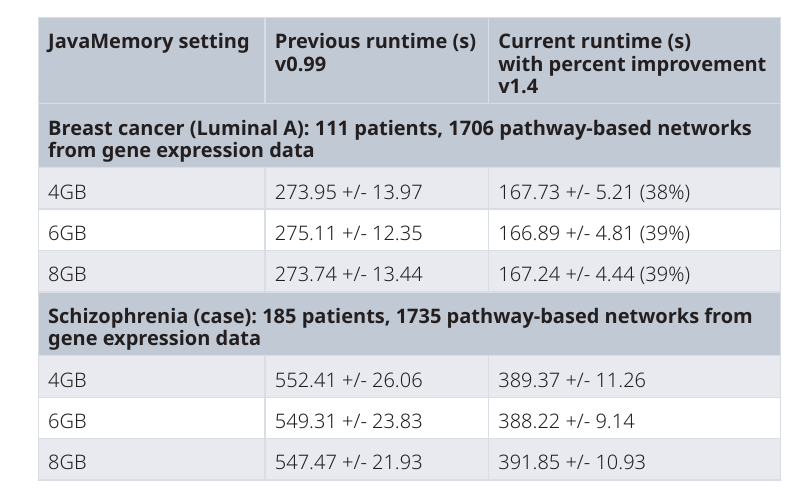
Table 2. Benchmarking performance improvement for netDx. Computation times are averaged over four runs of the same ten queries for feature-scoring one patient label, while limiting the executable to a single core. All tests were performed on an Intel Xeon @ 2.6GHz machine with 126GB of available RAM and 12